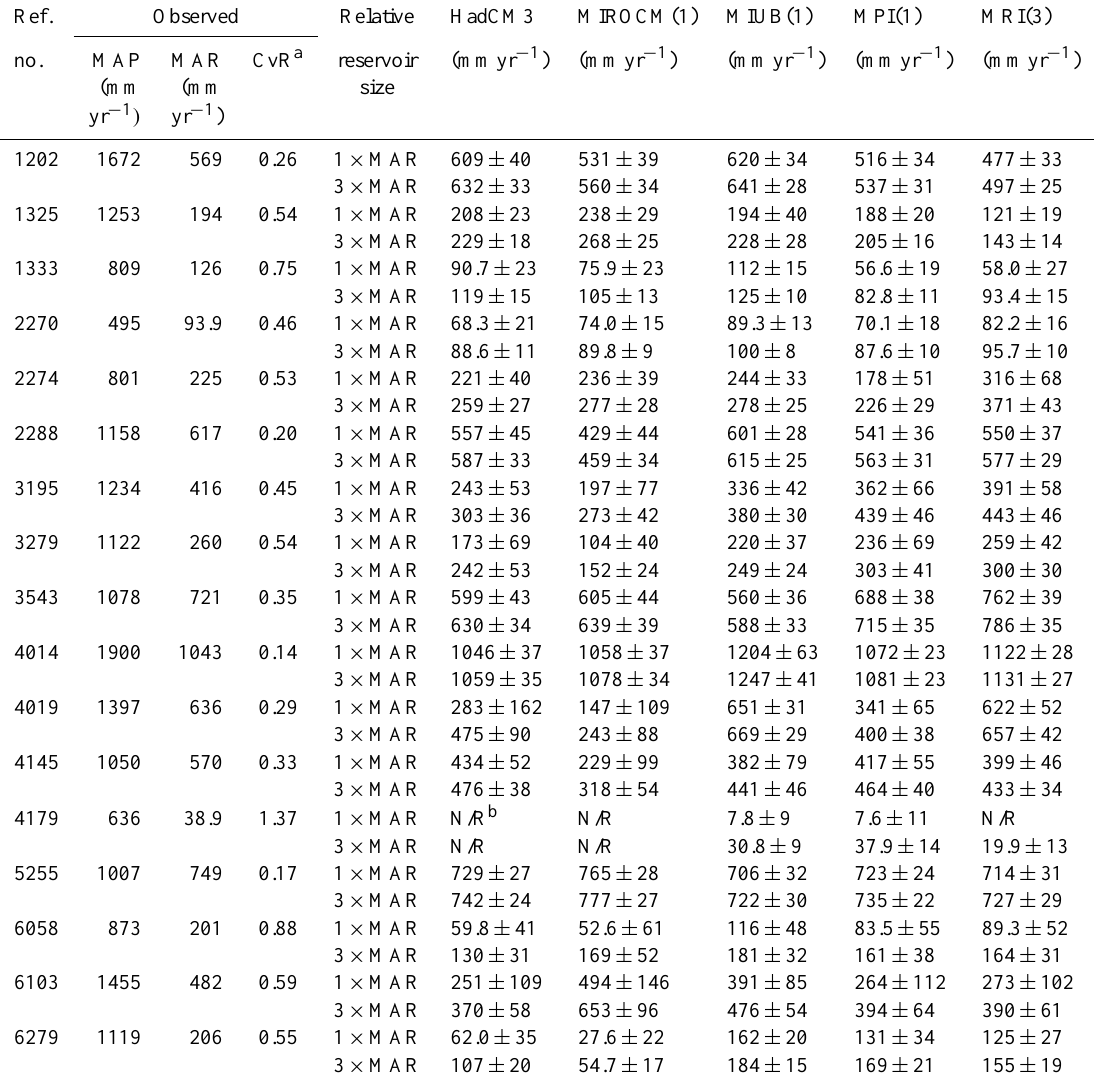
Table 7. Average and within-GCM uncertainty of reservoir yield (mmyr − 1 ) for 17 catchments using the Gould–Dincer Gamma reservoir storage model for two reservoir sizes ( τ = 1 × MAR and τ = 3 × MAR) and 95% reliability of draft. Average and uncertainty (standard deviation) are calculated from 100 bias-corrected replicates of precipitation and temperature passed through the PERM model for each GCM over the period 2015–2044 (A1B).